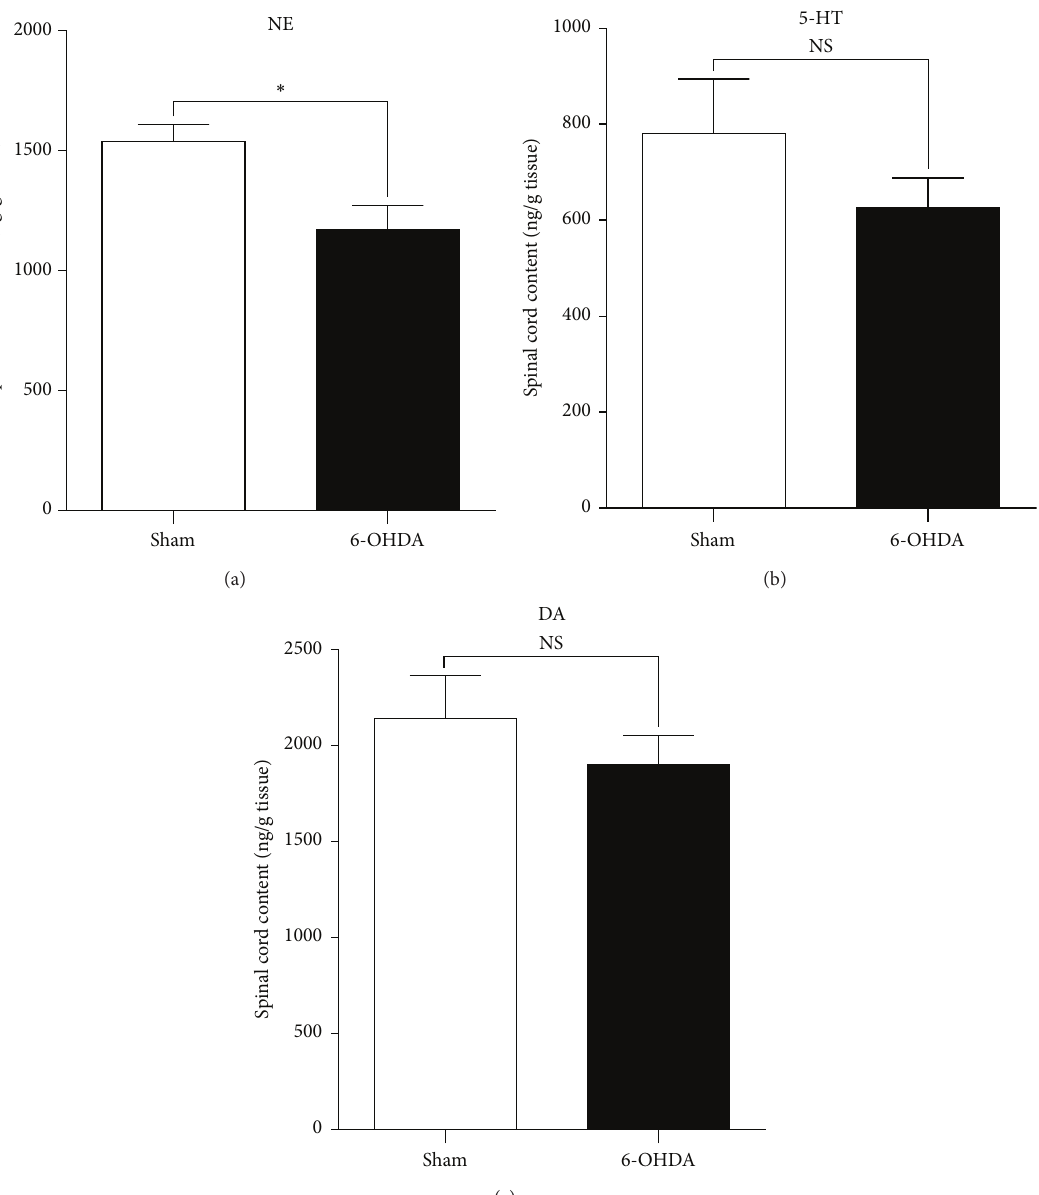
Figure 3: Change of NE, 5-HT, and dopamine (DA) content in the lumbar spinal cord in the 6-OHDA-lesioned rat model. Samples were collected at the 5th week after 6-OHDA-lesion and NE (a), 5-HT (b), and DA (c) content in the lumbar spinal cord were analyzed by HPLC. Compared to the sham group, the NE content significantly decreased in the 6-OHDA-lesioned animals ( ∗ 𝑃 < 0.05 compared to the sham group, 𝑛 = 4 for each group). 5-HT and DA content did not significantly change between the 6-OHDA-treated group and sham control group ( 𝑃 > 0.05 compared to the sham group, 𝑛 = 4 for each